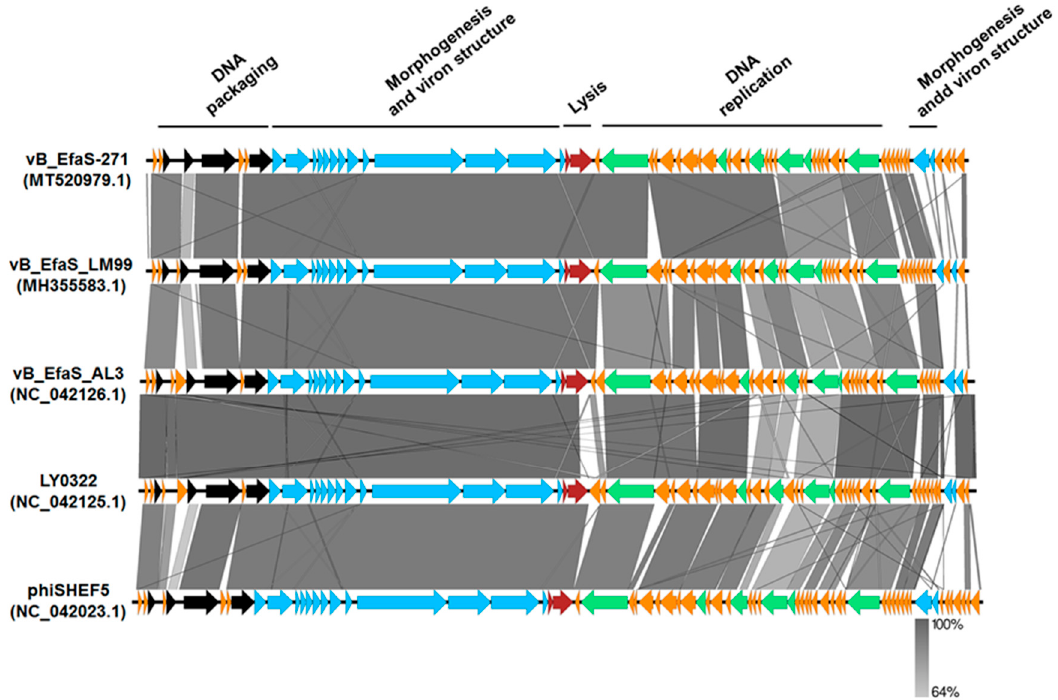
Figure 3. Multiple genome alignments of the vB_EfaS-271 bacteriophage and 4 other related enterococcal phages, vB_EfaS_LM99 (MH355583.1), vBEfaS_AL3 (NC_042126.1), LY0322 (NC_042125.1) and phiSHEF5 (NC_042023.1), created by using the EasyFig program. Open reading frames (ORFs) are shown as arrows to indicate the direction of transcription and are colored in accordance with their predicted functions: phage morphogenesis and virion structure (blue arrows), host lysis (red arrows), phage DNA replication (green arrows), and DNA packaging (black arrows). Orange arrows represent ORFs of unknown functions. The percentage of sequence similarity is shown as the intensity of the gray color. Vertical blocks between compared sequences indicate parts of the genome with at least 64% homology.